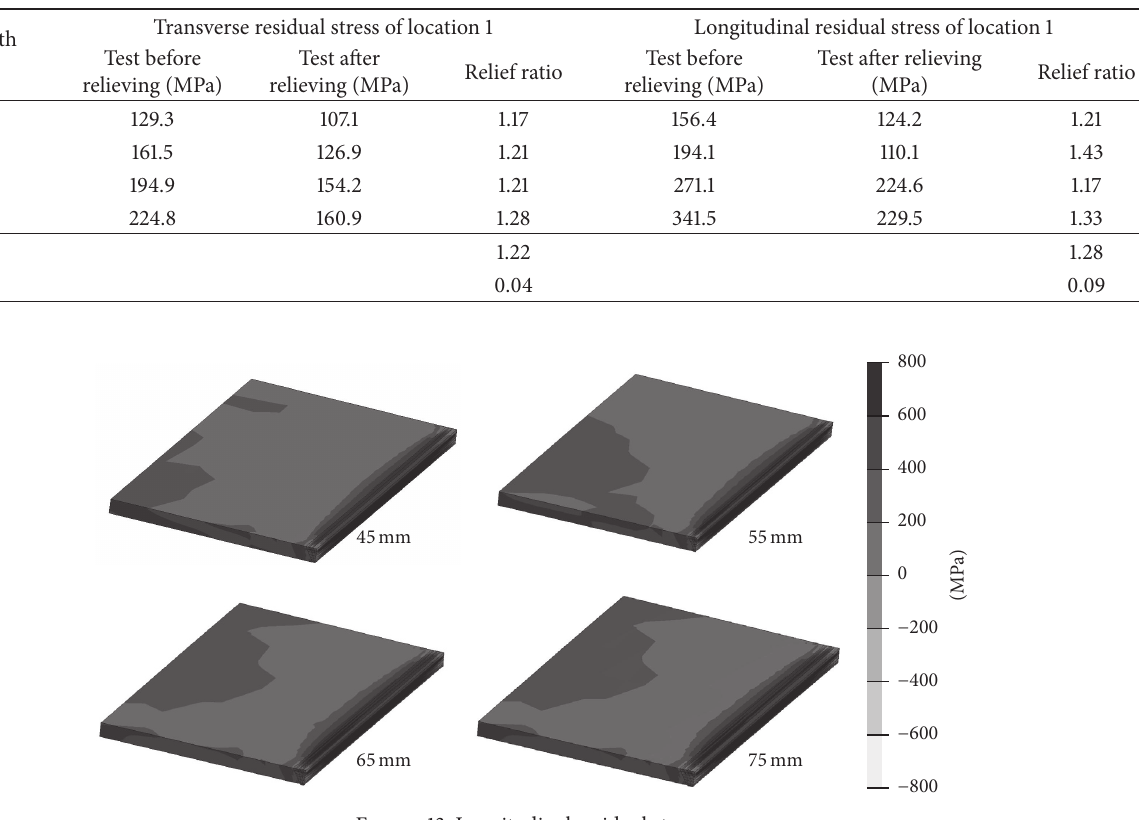
Table 5: Residual stress relief ratio.